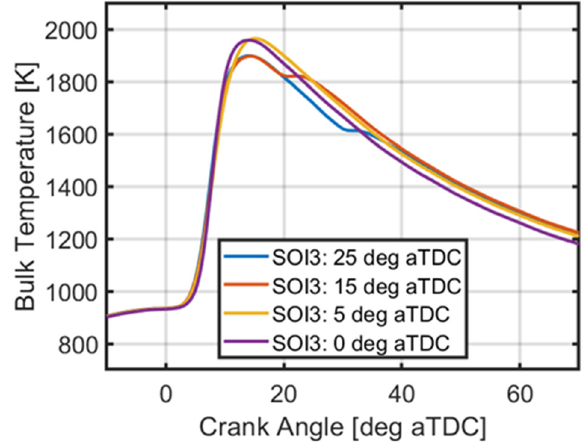
Figure 7. Bulk temperature vs. crank angle for a subset of mixing-controlled injection timing sweep. The legend indicates the mixing-controlled start of injection (SOI3) timing. The significant thermal NOx production threshold is ~1700–1800 K.